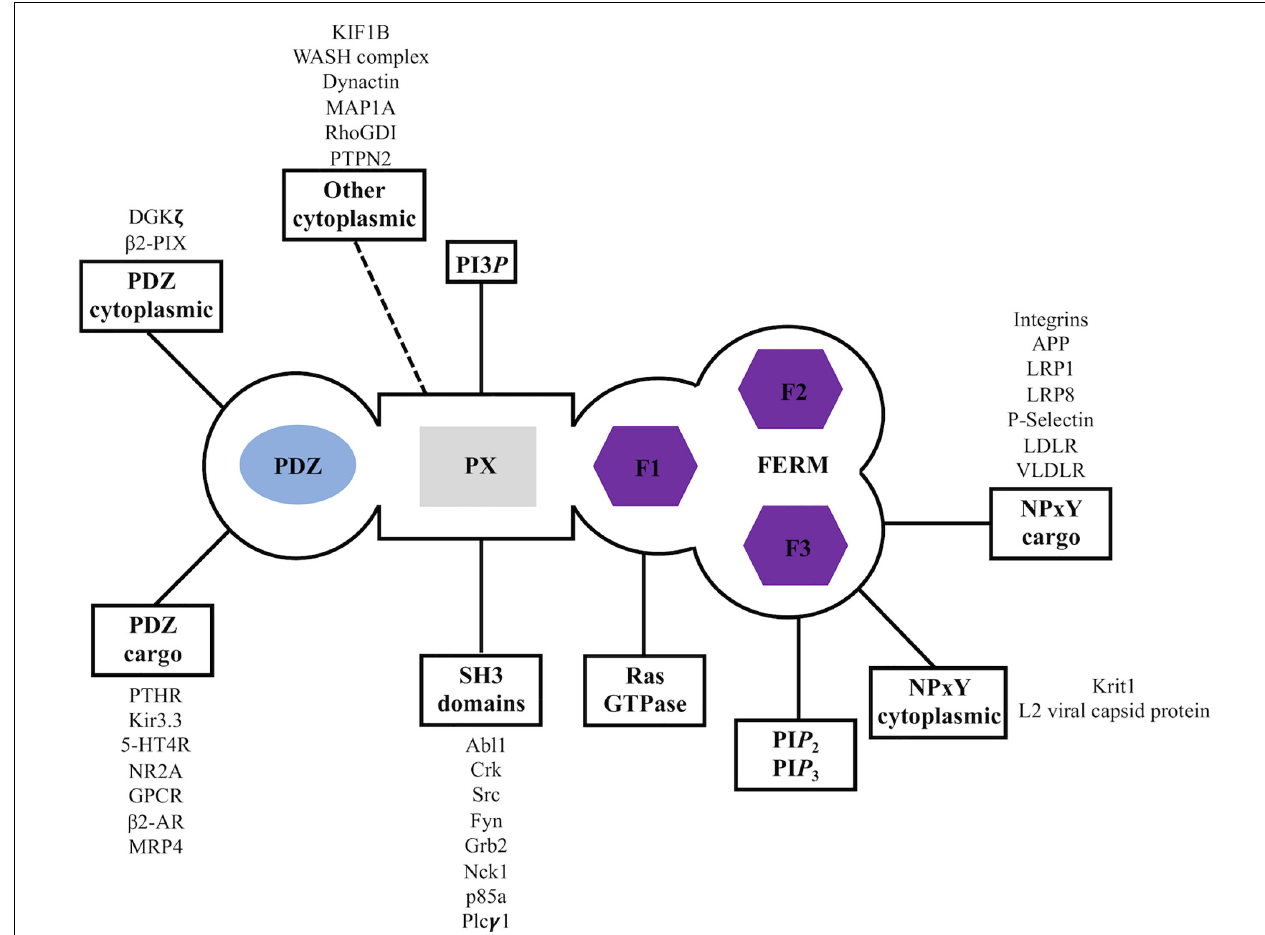
FIGURE 3 | Sorting nexin 27 (SNX27) interaction partners. Summary of reported binding partners for SNX27 structural